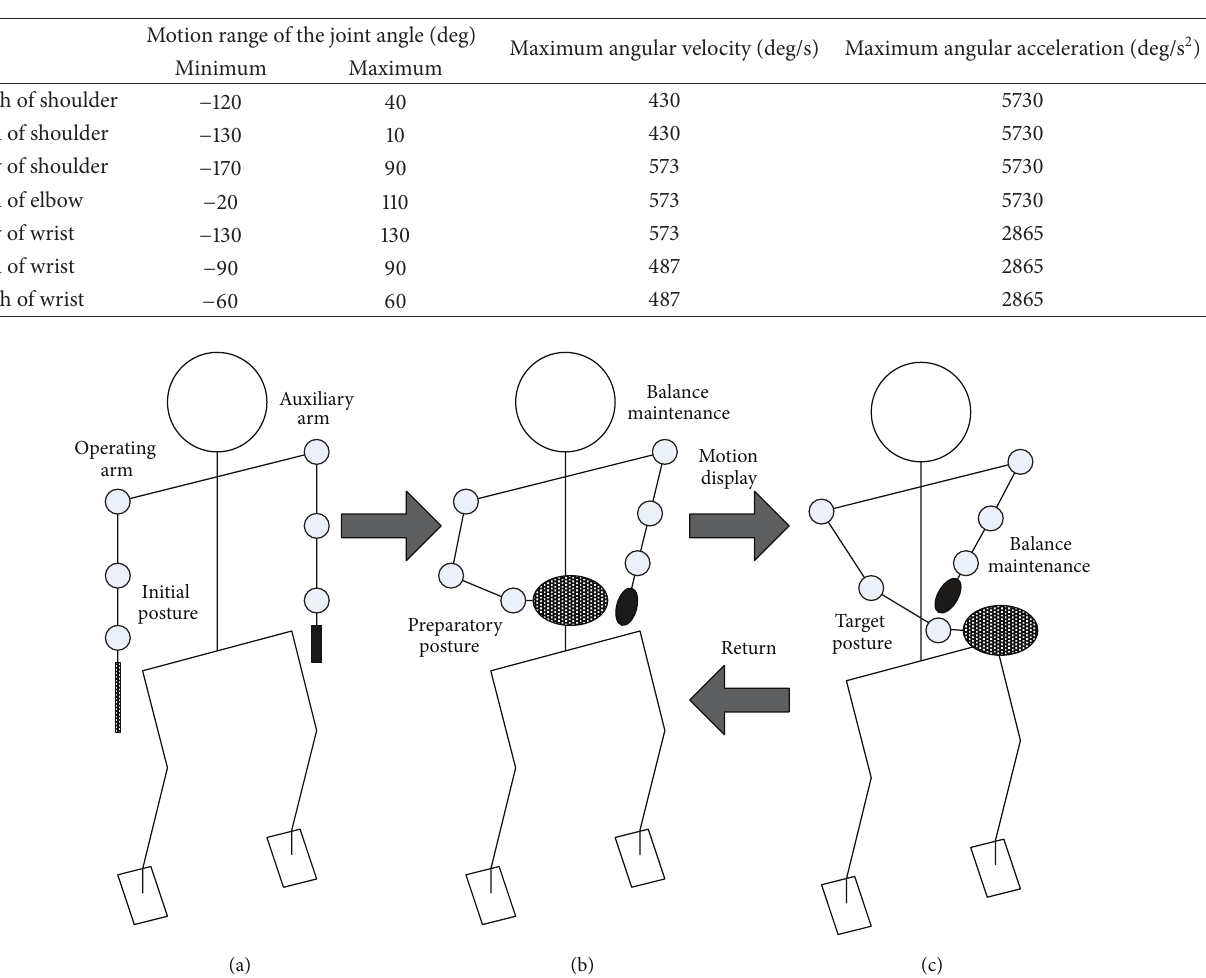
Table 2: Motion parameters of the arm joints.